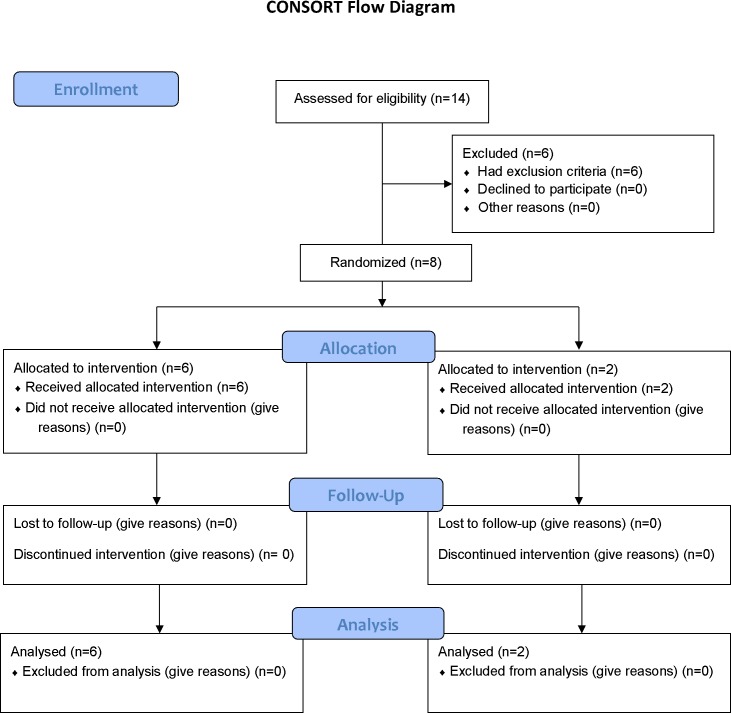
Flow diagram of patients screened and enrolled for the ARGISM-1 study.